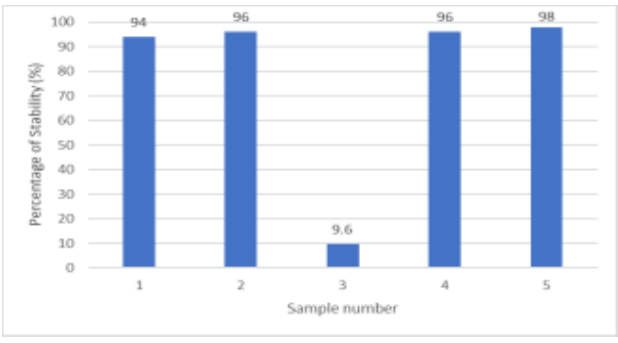
Figure 1: The stability of emulsion using different formulation